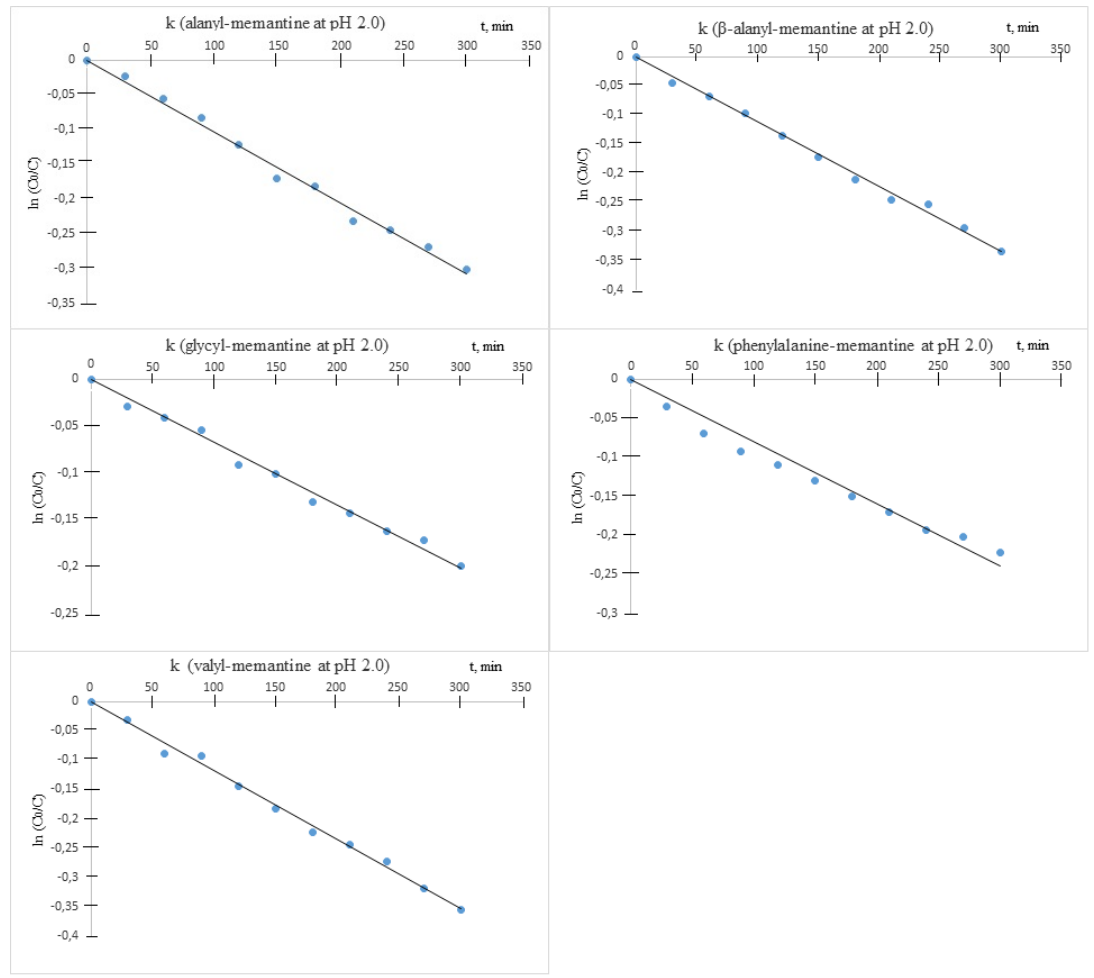
Figure 4. Changing of concentration of the examined memantine derivatives with time at pH 2.0. Under these conditions, all of the observed half-lives were more than 10 h. All tested compounds were also stable at pH 7.4 (Figure 5).